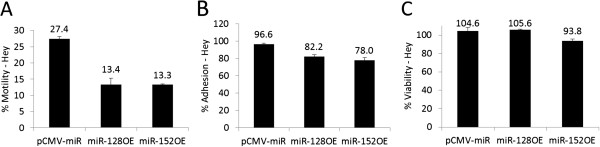
Ovarian cancer cell adhesiveness and motility is inhibited by miR-128 and miR-152. After transfection with, miR-128 overexpression construct (miR-128OE), miR-152 overexpression construct (miR-152OE), or Empty vector (pCMV-miR), Hey cells were plated on A) an 8 micron pore membrane for a 6 hour directed motility assay. B) Human matrix-coated membrane for a 2 hour adhesion assay. C) Viability of miRNA overexpression construct transfected Hey cells 24 hours post transfection was determined by a cell proliferation assay.